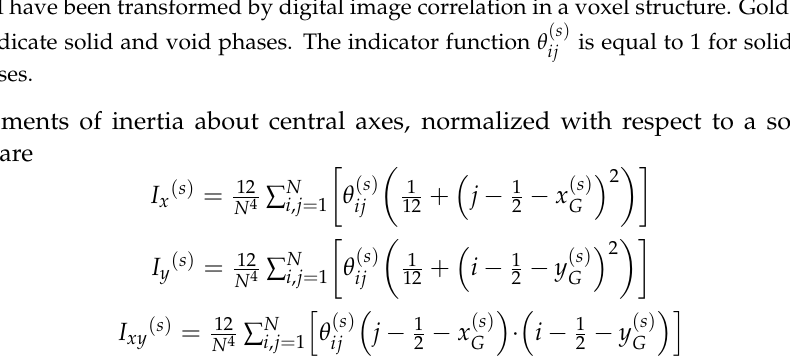
( s ) is equal to 1 for solid and 0 for ij